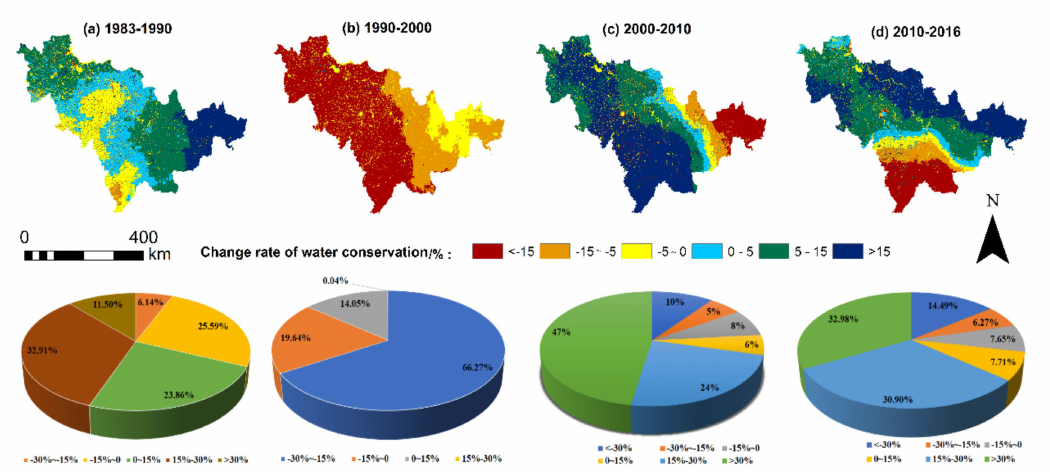
Figure 8. Spatial change and change rate of water conservation distribution in Jilin province in ( a ) 1983–1990, ( b ) 1990–2000, ( c ) 2000–2010, ( d ) 2010–2018.